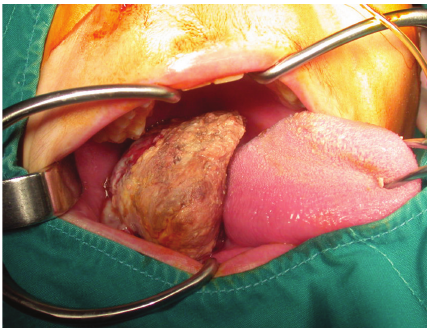
Figure 2: The preoperative examination showed a mass of the right retromolar area with a diameter of 7 × 6 × 4cm extending deeply from the posterior ridge of the left lower alveolar process and gingivobuccal sulcus.